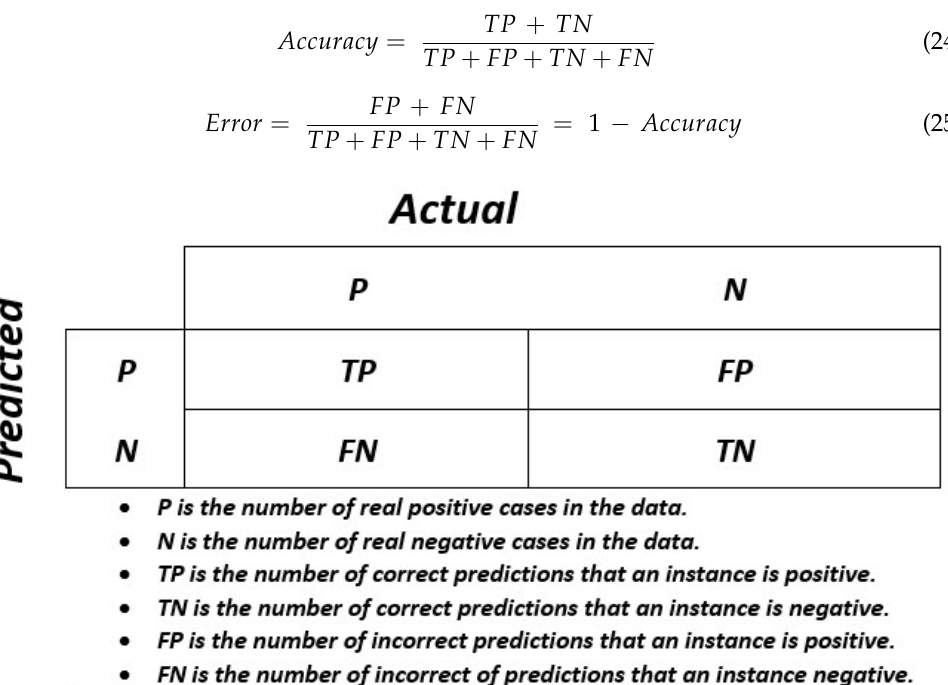
Figure 3. A basic form of a confusion matrix.